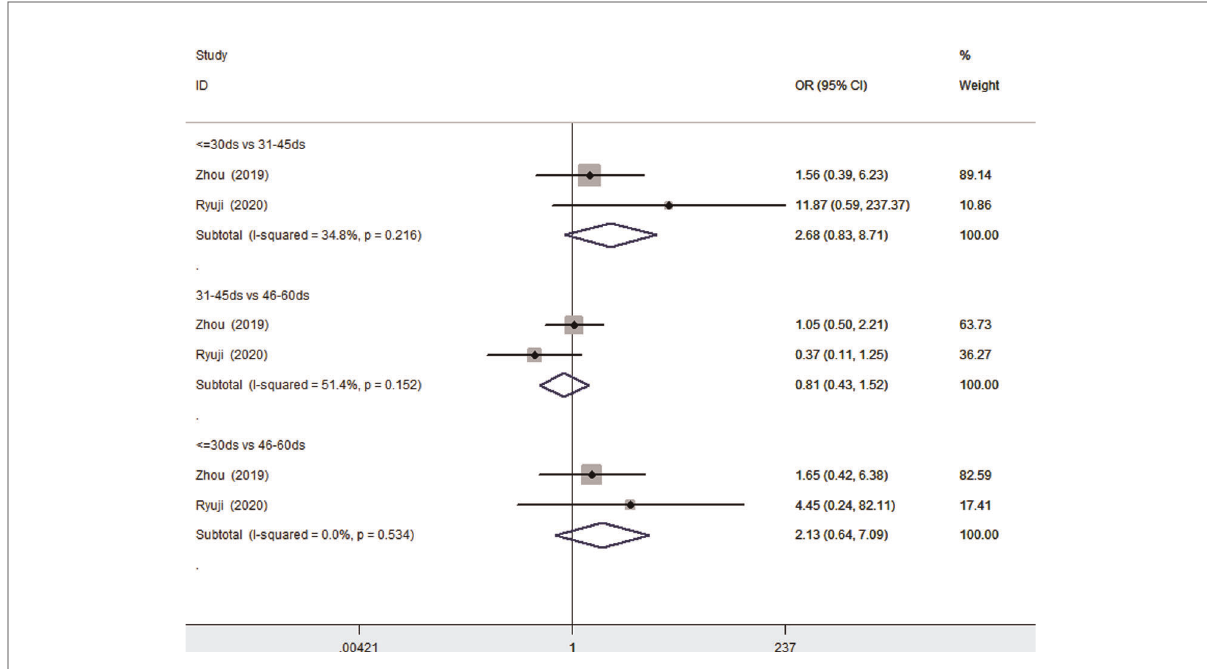
FIGURE 4 Forest plots for JCR of ≤ 30 days vs. 31 – 45 days, 31 – 45 days vs. 46 – 60 days, ≤ 30 days vs. 46 – 60 days. JCR, jaundice clearance